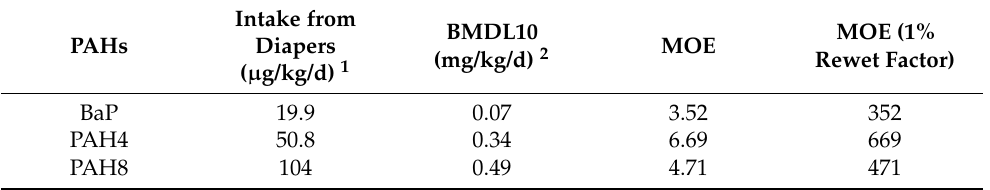
Table 7. Margin of exposure (MOE) for polycyclic aromatic hydrocarbons (PAHs) with the scenario 2.2 equation or the scenario 2.1 equation incorporating the rewet factor of